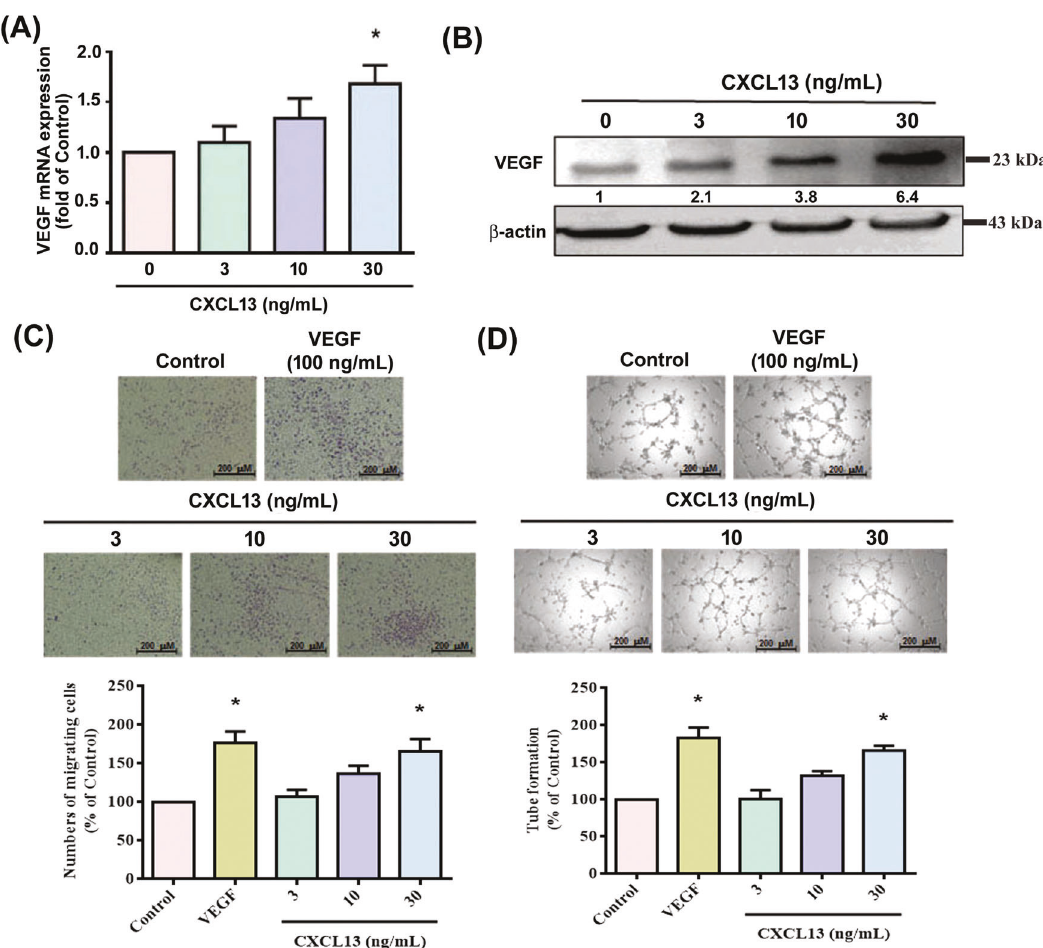
(3 – 30 ng/ml); cell migration ( n = 5) and tube formation ( n = 5) were measured. * p < 0.05 versus the control